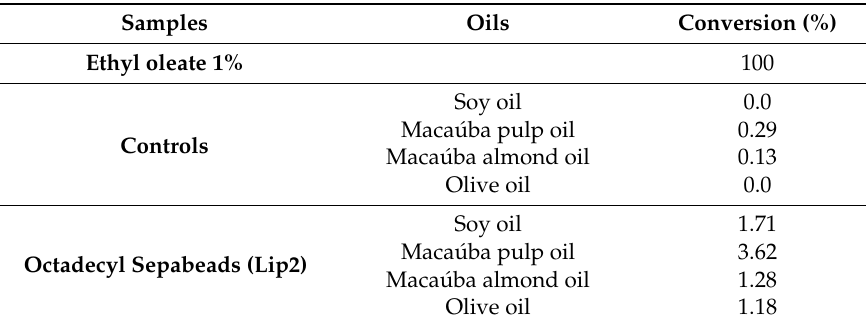
Table 5. Conversion rate of the transesterification reaction to Lip2 derivative.